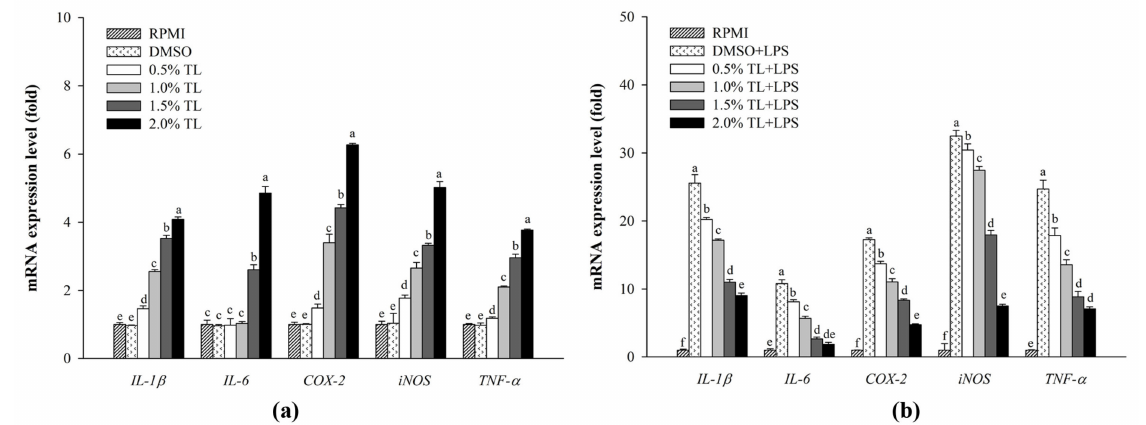
Figure 3. The effects of lipid extracted from A. personatus eggs on immune-related mRNA expression. ( a ) mRNA expression in RAW264.7 cells without LPS stimulation; ( b ) mRNA expression in LPS-stimulated RAW264.7 cells. Data are presented as means ± standard deviation ( n = 3). The letters a, b, c, d, e, and f indicate significant differences ( p < 0.05) between treatment groups. TL = total